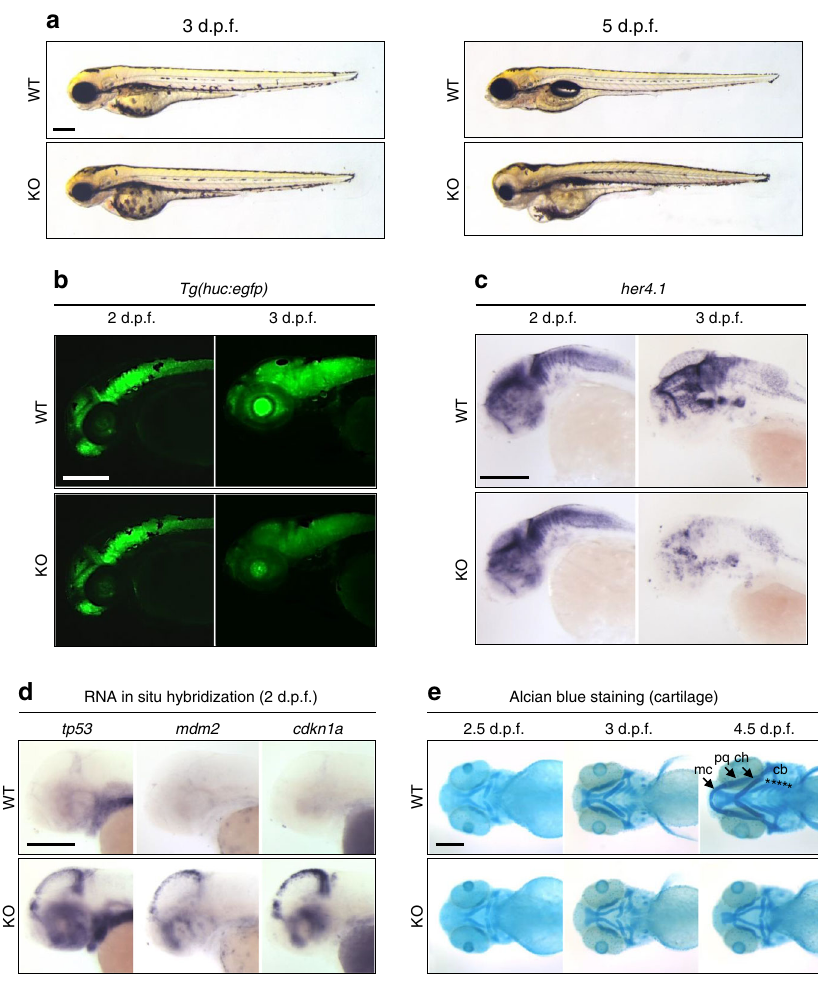
Fig. 2 fam50a KO zebra fi sh display central nervous system and craniofacial patterning defects. a Representative bright fi eld lateral images of WT and fam50a KO are shown at 3 and 5 days post-fertilization (dpf). Morphology of fam50a KO was relatively normal at 3 dpf; repeated four times. However, at 5 dpf, fam50a KO showed craniofacial abnormalities; repeated fi ve times. Number of larvae assessed with similar results: 3 dpf, n = 56; 5 dpf, n = 44. b Fluorescent lateral images of WT and fam50a KO larvae on a Tg(huc:egfp) neuronal reporter. No difference between WT and fam50a KO was detected in the anterior structures at 2 dpf. However, at 3 dpf, a prominent reduction of GFP-positive neurons was observed in KO larvae. Number of larvae assessed with similar results: 2 dpf, n = 20; 3 dpf, n = 20. c Whole-mount in situ hybridization (WISH) of her4.1 , a molecular marker of neurogenesis, indicated a depletion of neurons in fam50a KO compared to WT at 3 dpf; repeated. Number of larvae assessed with similar results: 2 dpf, n = 24; 3 dpf, n = 21. d Apoptosis markers are elevated in fam50a KO larvae at 2 dpf. Note the induction of tp53 and tp53 target genes, mdm2 and cdkn1a (p21) in the cell proliferative zone in the midbrain region fam50a KO larvae at 2 dpf; repeated. Number of larvae assessed with similar results: tp53 , n = 41; mdm2 , n = 52; cdkn1a , n = 39. e Representative ventral images of Alcian blue staining of cartilage structures shows severe defects in cartilage development that become apparent at 3 dpf. Meckel ’ s cartilage, mc; palatoquadrate, pq; ceratohyal arch, ch; and ceratobranchial arches, cb. Number of larvae assessed with